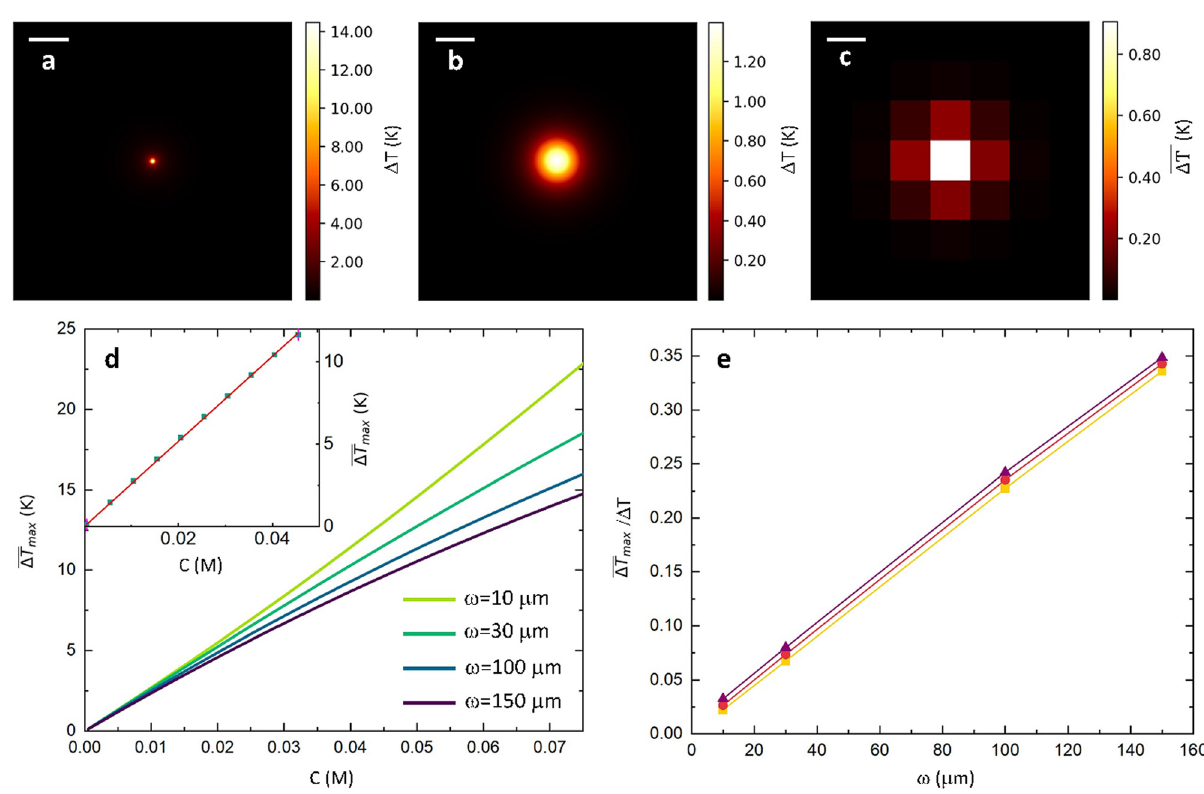
Figure 3: Quanti fi cation of the concentration of photo - thermal probes by super - resolved photo - activated thermography. ( a )